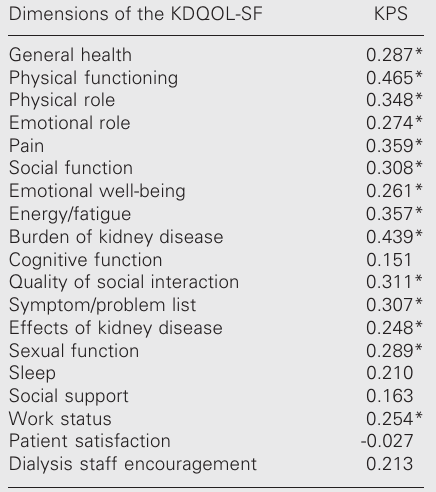
Table 5. Pearson’s correlation coefficient between the mean values of the dimensions of the Brazil- ian Portuguese version of the Kidney Disease and Quality of Life - Short Form and the mean values of the dimensions of the Karnofsky Performance Scale (KPS, N =